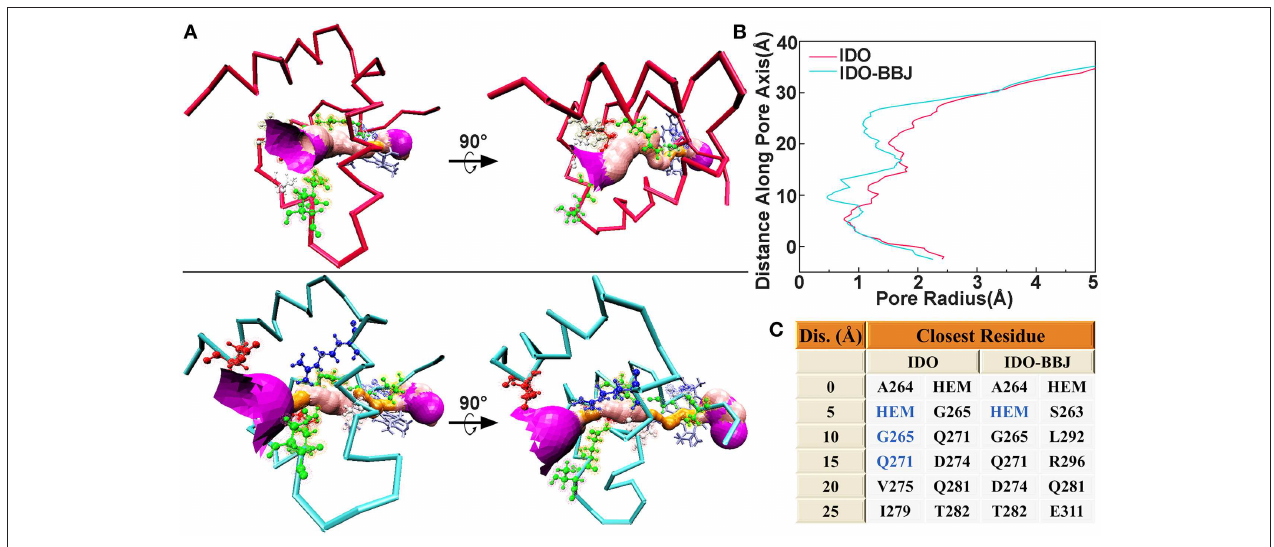
FIGURE 5 | Hole analyses of G251-P300 segment in the IDO and IDO-BBJ systems. Tunnel visualizations (A) . The radius of gold pore is too small for accommodating water molecules, while the pink and purple pores, respectively allow a single and over two water molecules to pass through. Pore radius profiles vs. position along pore axis (B) . The closest residues to tunnels at different positions along pore axis (C) .